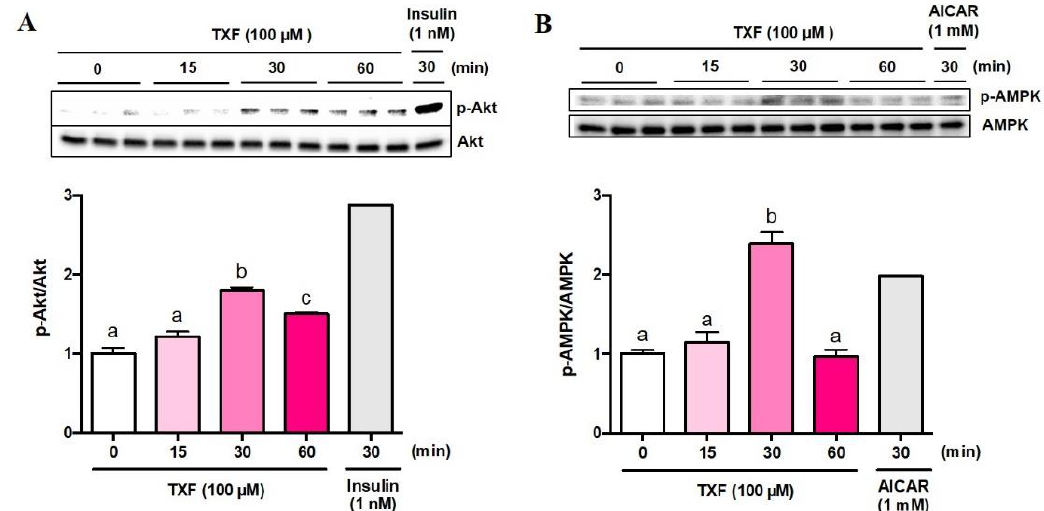
Figure 2. Time-dependent changes in phosphorylation of Akt ( A ) and AMPK ( B ) by TXF (100 µM) in L6 myotubes. Each value represents the mean ± SEM for 3 dishes (60 mm in diameter). Insulin ( n = 1) and AICAR ( n = 1) were used as positive controls for Akt and AMPK pathways, respectively, and excluded from statistical analyses. Values not sharing a common letter were significantly different at p < 0.05 by the Tukey – Kramer multiple comparison test.